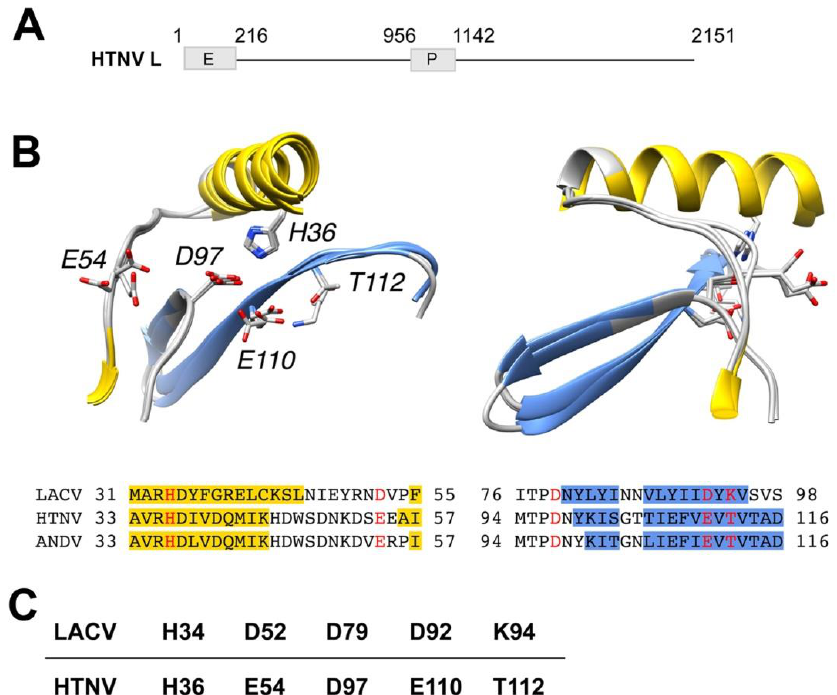
Figure 1. Model of the putative active sites of prototypic Hantaan virus (HTNV) and Andes (ANDV) superposed on the active site of orthobunyavirus La Crosse (LACV). ( A ) Schematic representation of HTNV L protein. The L segment of the prototypic HTNV strain 76/118 has 6533 nucleotides and encodes the L protein of 2151 amino acids (aa). HTNV L contains a polymerase (P) domain (aa 956–1142) and a putative endonuclease (E) domain (aa 1–216). ( B ) Models of the putative active sites of HTNV and ANDV superposed on the active site of LACV. Ribbon diagrams of LACV (PDB entry 2XI5), HTNV and ANDV after structural superposition of key active site residues. Secondary structure classifications was calculated using definition of secondary structure proteins (DSSP) [33] for LACV or predicted using the method/program PSI-PRED [34]. Helix residues have been colored yellow and β -strand residues have been colored blue in the ribbon diagrams as well as in the alignment, according to DSSP or PSI-PRED results, respectively. Annotations in ribbon diagrams follow the HTNV residue numbering in the alignment. Key residues are colored red in the alignment and shown with side chains in the ribbon diagrams. The ribbon diagrams to the right have been rotated 90 degrees around the vertical coordinate axis. ( C ) Amino acid residues of the active site of HTNV L endonuclease derived from the model in ( A